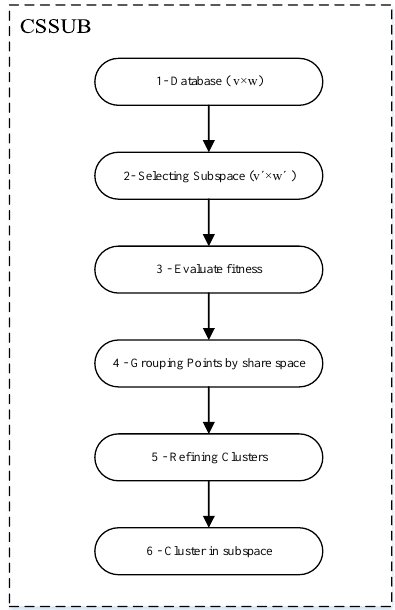
Fig. 1. Stages of CSSUB